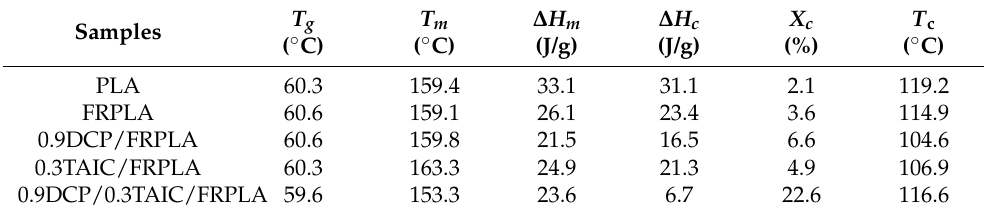
Table 4. The DSC data of PLA and flame-retardant PLA composites.